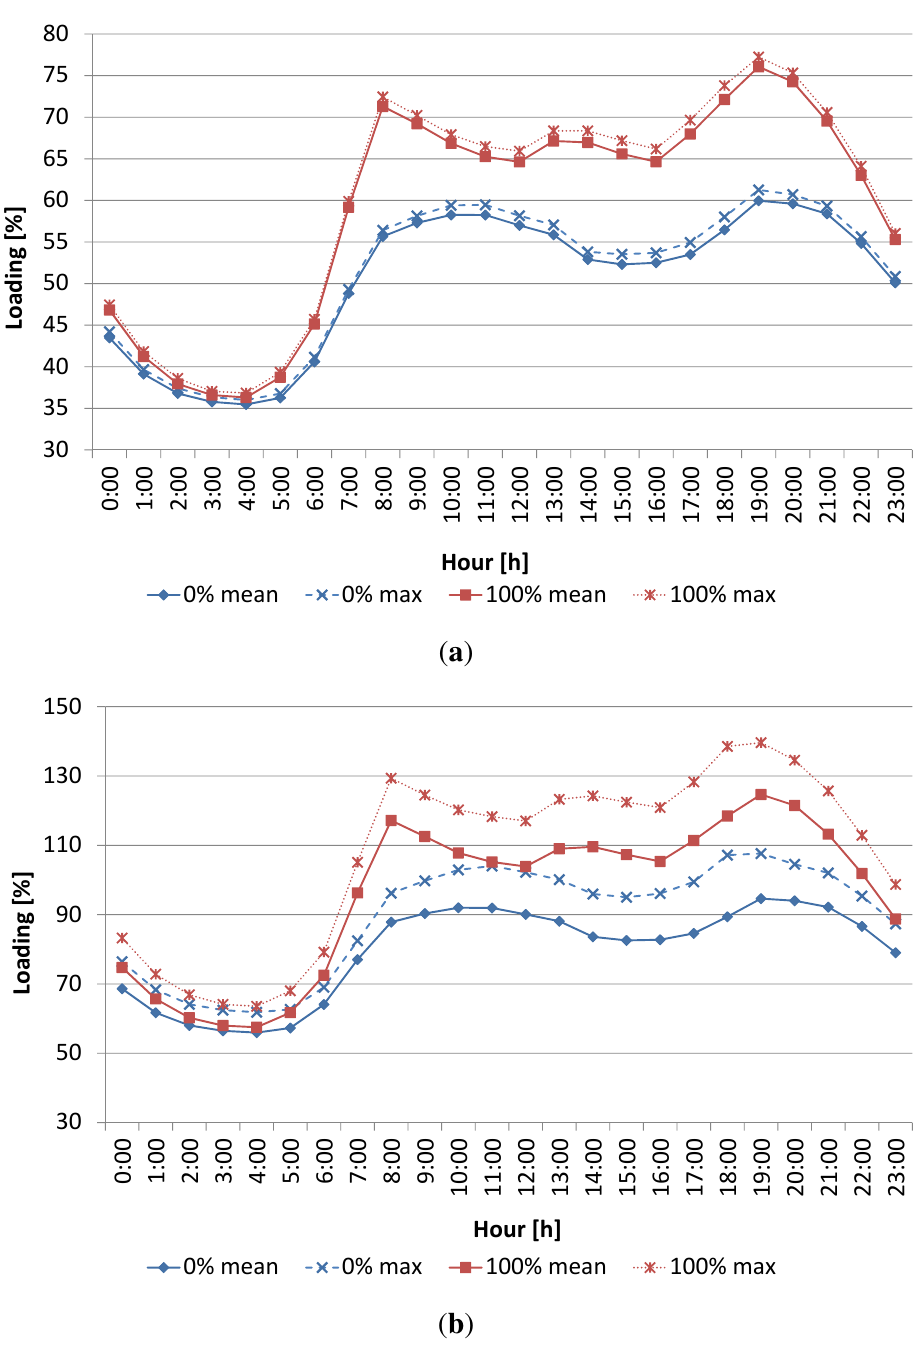
Figure 14. Grid’s loading profile with an EV’s penetration of 100% recharging at the end of each travel. ( a ) Loading profile of the line L1; ( b ) Loading profile of the